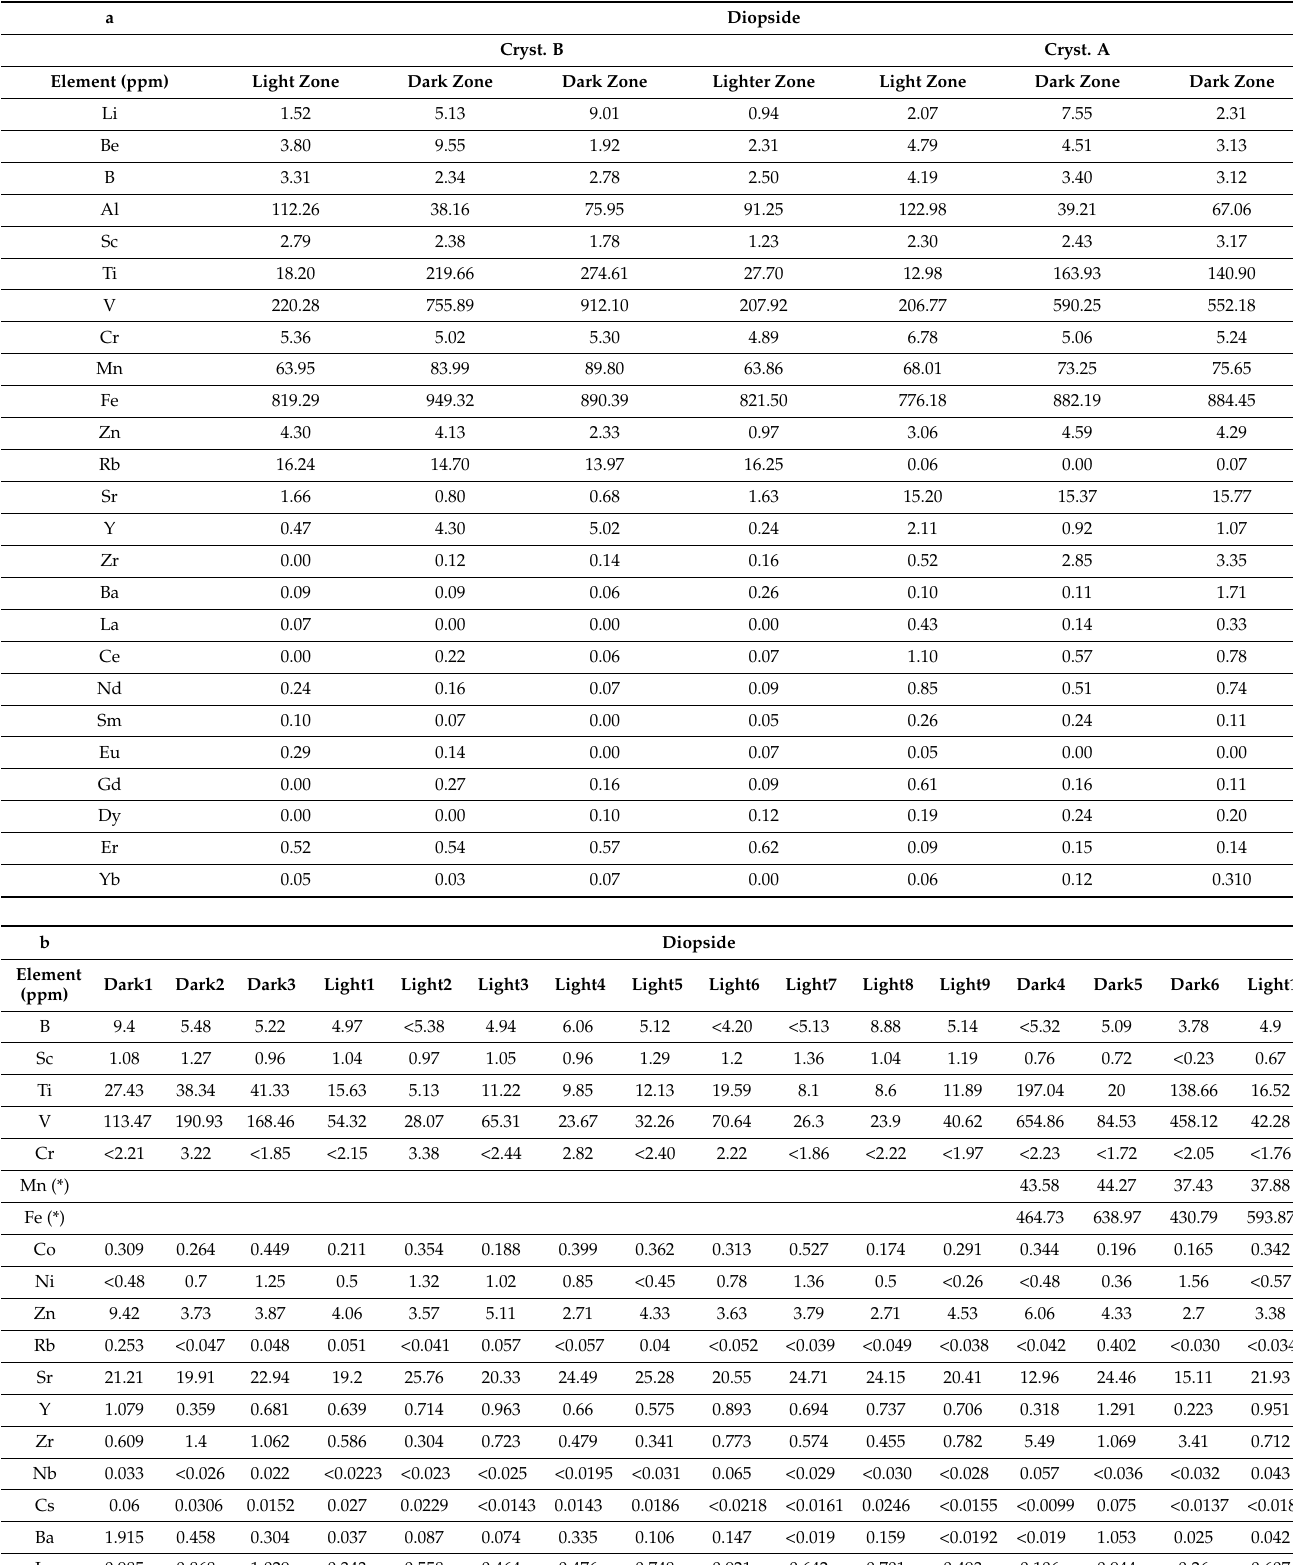
Table 5. ( a ) LA-ICP-MS investigations carried out on two crystals of diopside (A and B) from area 1 of Figure 9a (left side of the Sissonevalley); ( b ) LA-ICP-MS investigations on blue diopside from lens of Figure 11a (right side of the Sissone valley). (*) Mn and Fe were analyzed only in the last four analysis